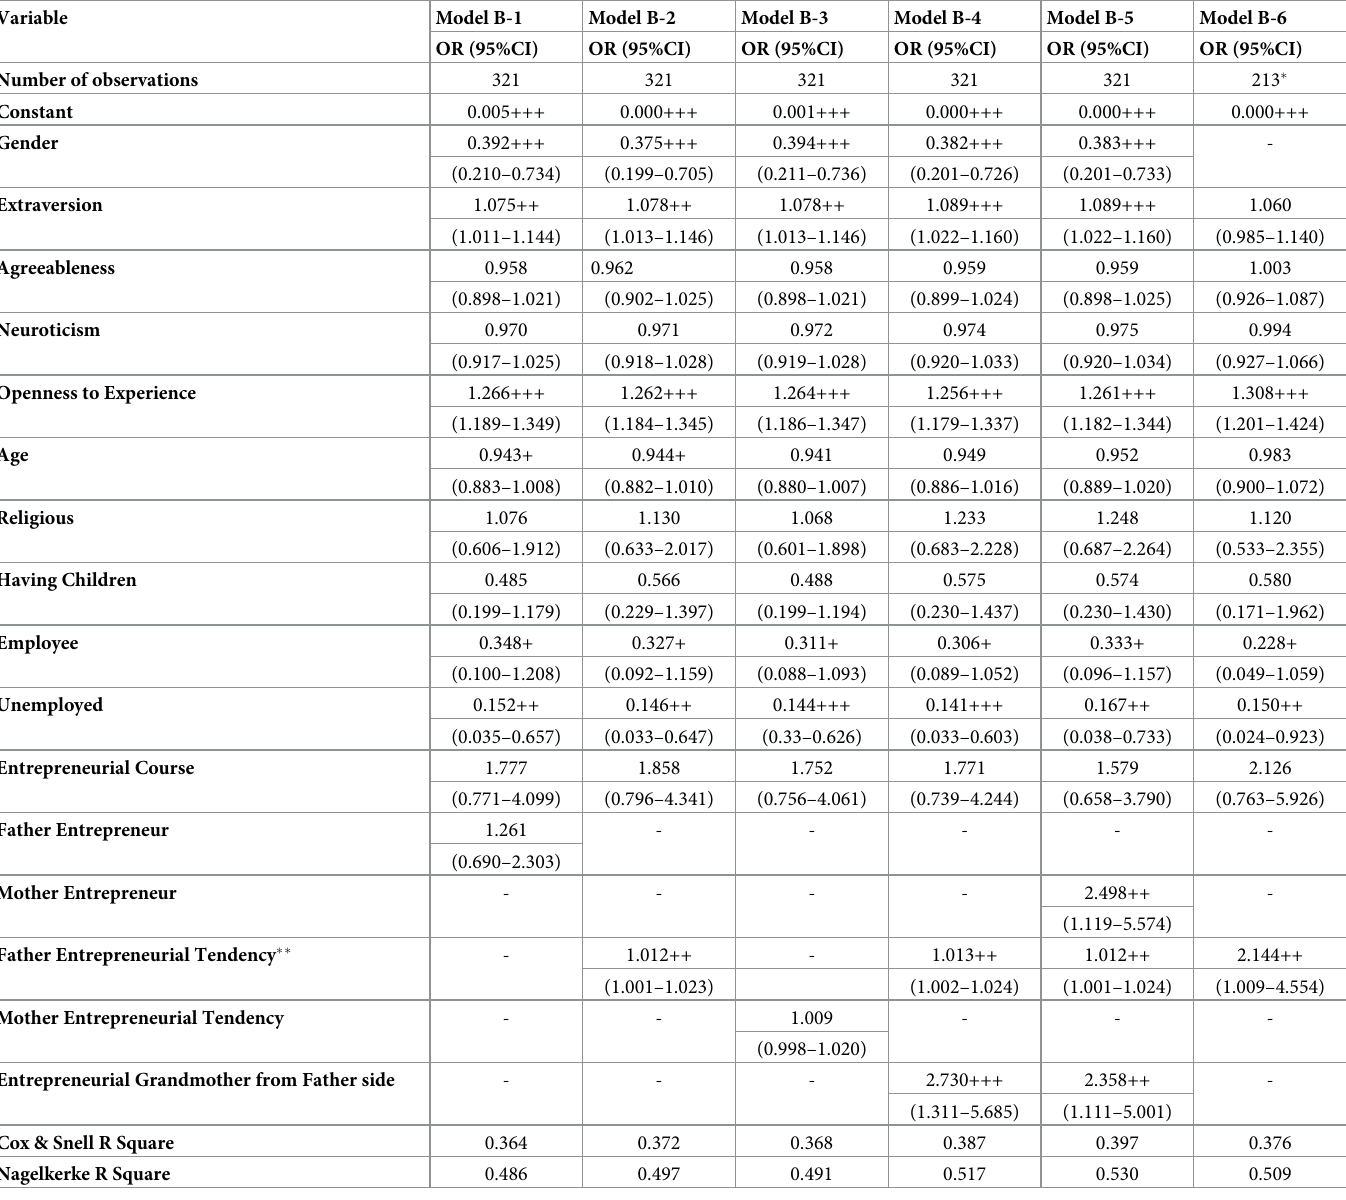
Table 5. Factors associated with entrepreneurial tendency and parental